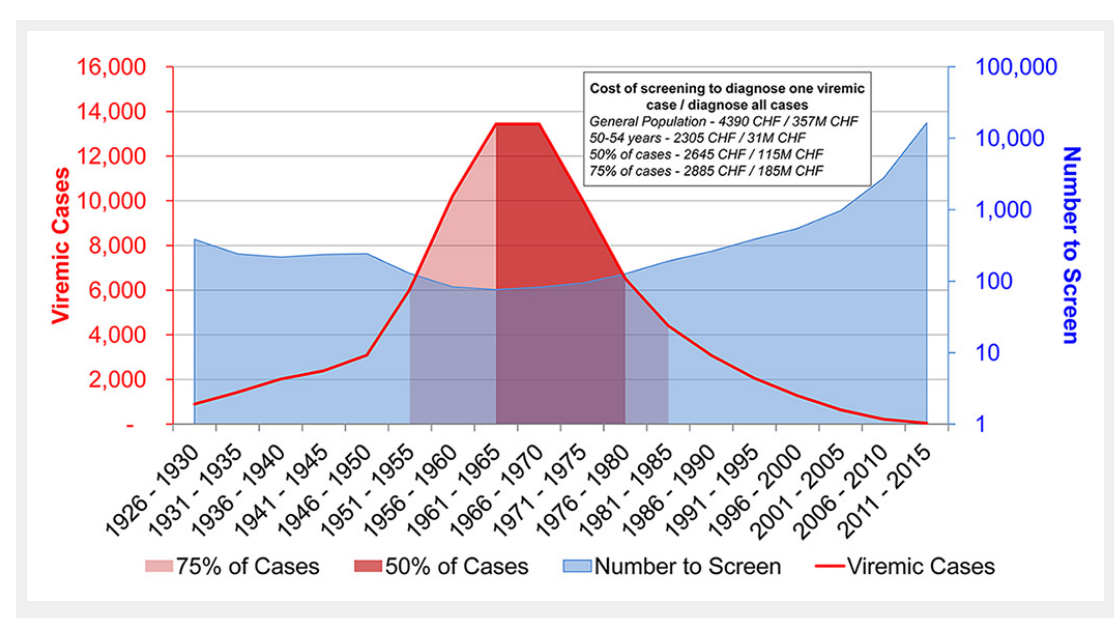
Figure 1 Percent of cases by 5-year birth cohort, the number of individuals needed to test in order to diagnose one viraemic case, and the associated cost to diagnose one viraemic case by birth cohort of